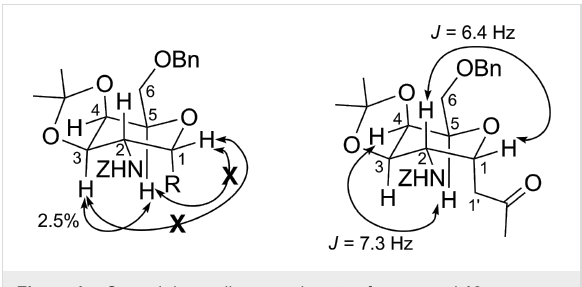
Figure 1: nOe and decoupling experiments of compound 12